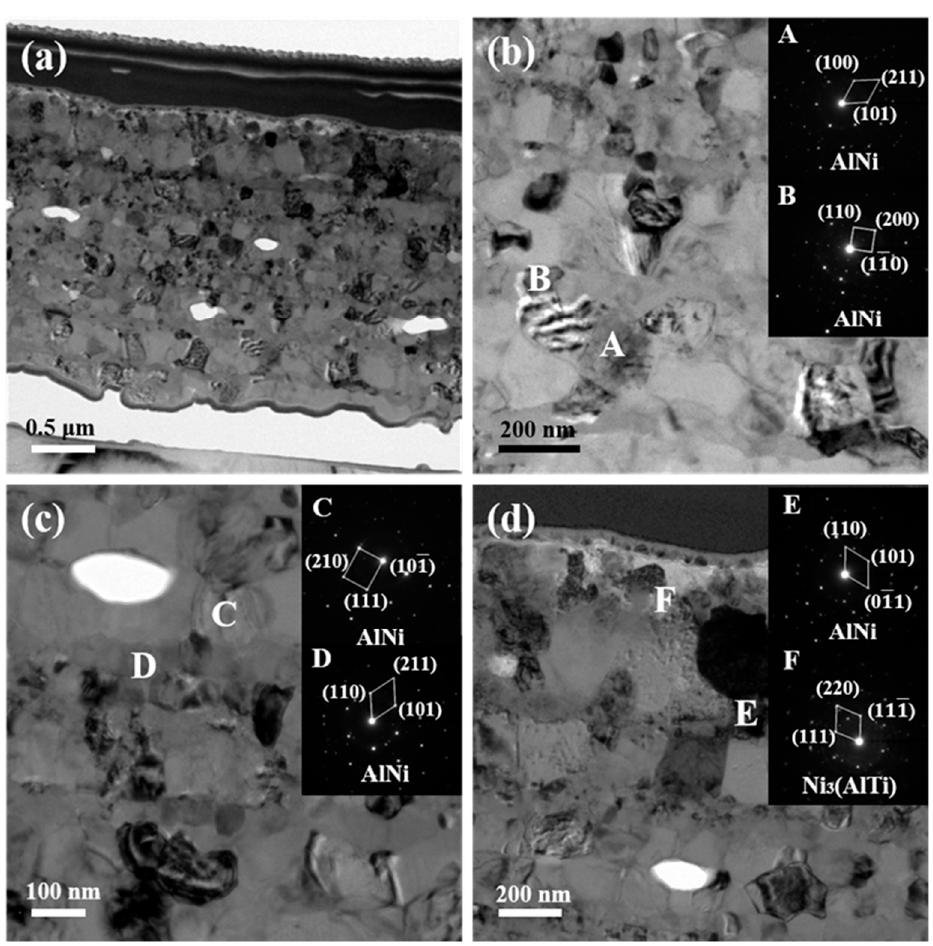
Figure 8. TEM images together with selected area electron diffraction patterns of the ATNT foil after annealing at 873 K for 3 h: ( a ) the whole morphology; ( b ) the bottom region; ( c ) the middle region; ( d ) the top region.